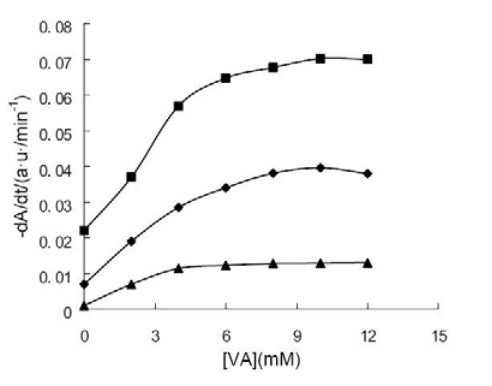
Fig. 4 Effects of the VA concentration on the initial rate of the LiP catalyzed oxidation of PR at three largely different H 2 O 2 (as initiator) concentrations. Conditions: λ = 500 nm; [PR] = 40 μ M; [LiP] = 0.1 μ M;[H 2 O 2 ] = 10 μ M( ), 60 μ M( ), 120 μ M ( ).